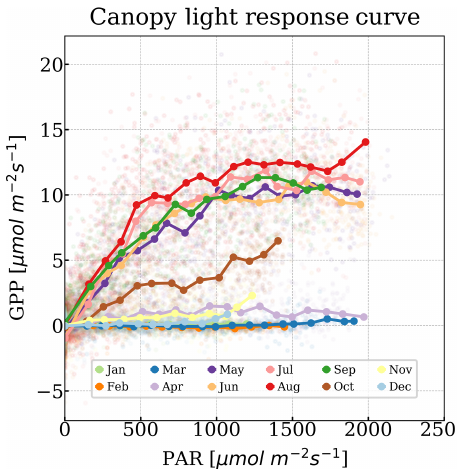
Figure 2. Half-hourly GPP as a function of PAR during the mea- surement period. Points were colored by month. Bold points were the median GPP when PAR was binned every 100µmolm − 2 s − 1 approximately. The solid lines represent the canopy light response